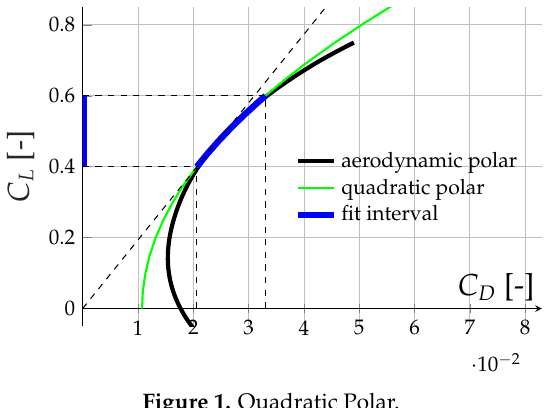
Figure 1. Quadratic